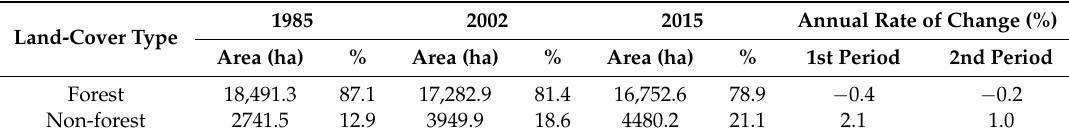
Table 7. Annual forest-cover change detection.